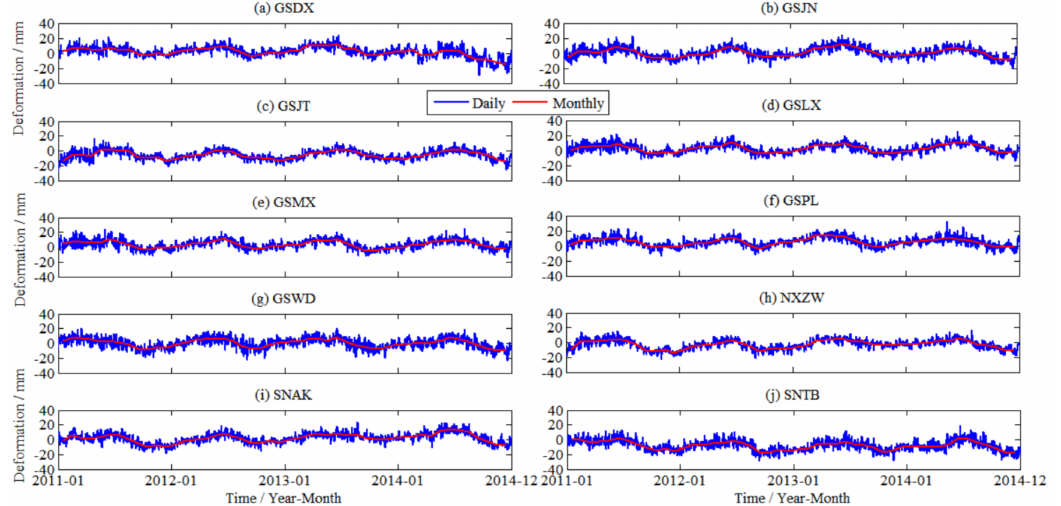
Figure 3. Daily and monthly variation time series of geodetic height at 10 CORS